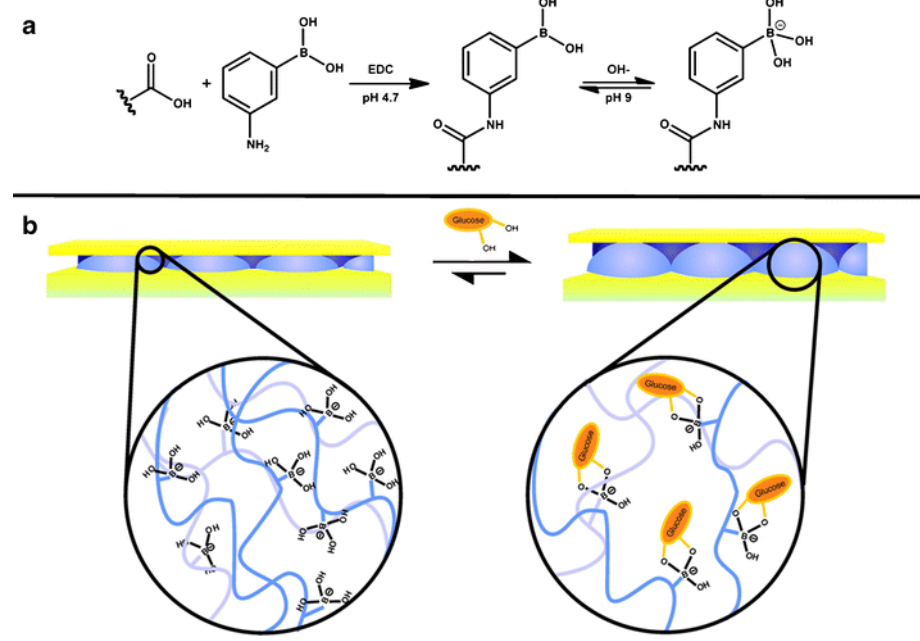
Figure 6. Reaction scheme for ( a ) the functionalization of the acrylic acid moieties on the microgel with 3-aminophenylboronic acid (APBA) followed by the activation of the boronic acid with base and ( b ) a cartoon depiction of the glucose responsivity of an APBA-functionalized microgel etalon at pH 9. Reproduced with permission from [23].